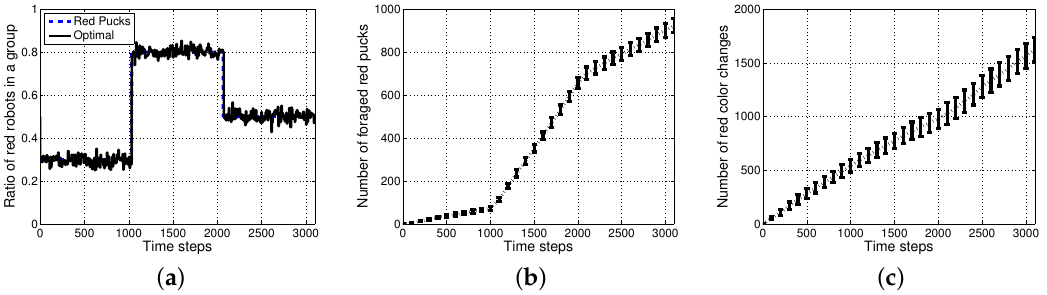
Figure 6. Result of an optimal method using a stochastic approach. ( a ) Ratio of red robots in a group; ( b ) number of foraged red pucks; ( c ) number of task changes in foraging for red